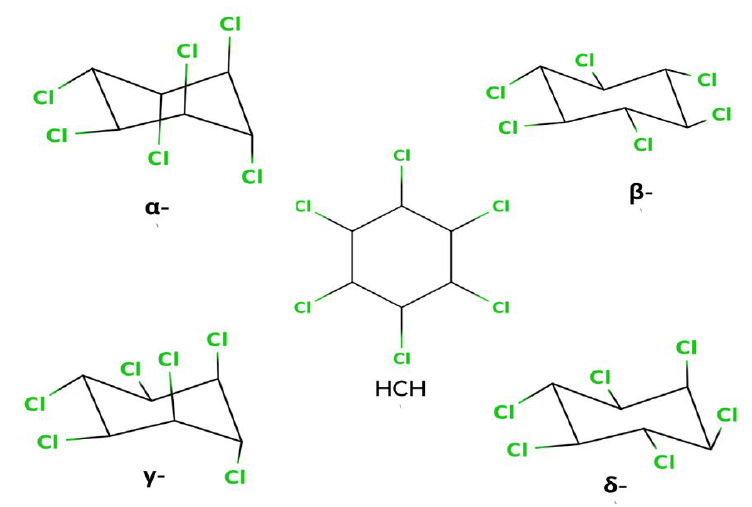
Figure 1. Isomeric Structures of HCH.